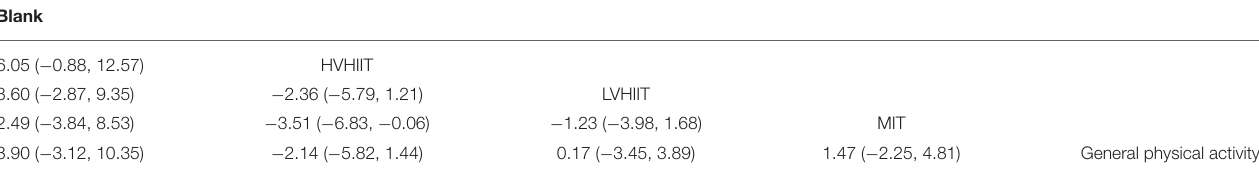
TABLE 5 | The league table of the interventions for rest heart rate (HR). Blank